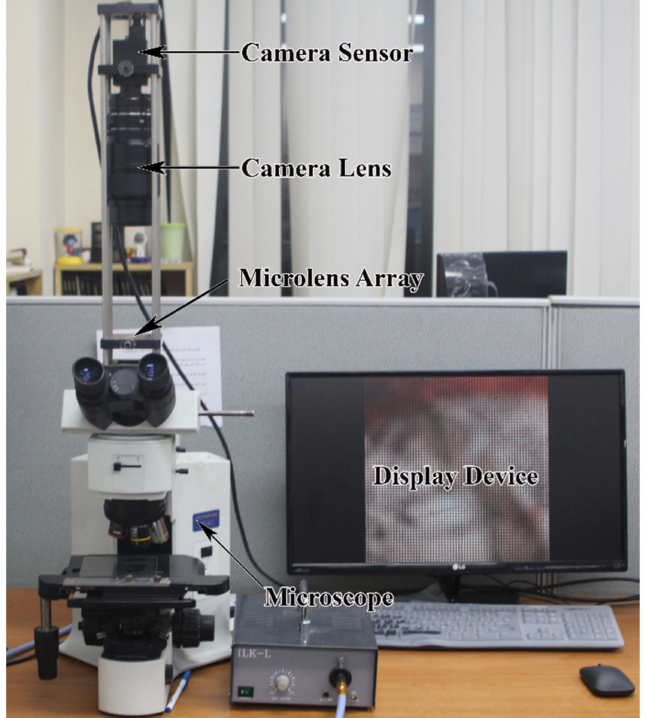
Figure 6. Experimental setup for the proposed IIM resolution enhancement system. The micro lens array (MLA) is placed between the camera sensor and the specimen, and the captured EIA is displayed in the display in